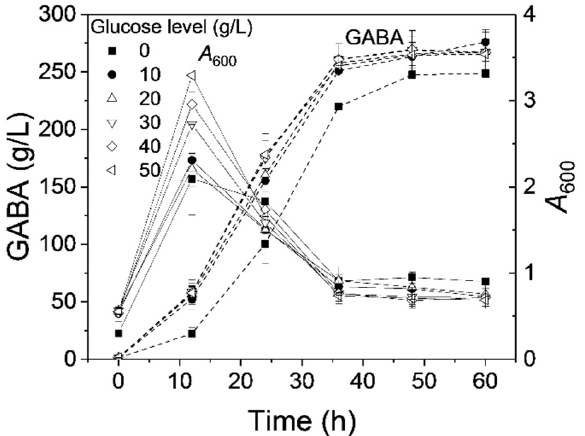
Figure 6. The effect of seed medium glucose content on GABA production and cell growth. Inocula prepared using seed media with different levels of glucose were used for the fermentation experiment, which was performed in a 250 mL Erlenmeyer fermentation flask at 30.0 °C. Cell growth was expressed as A 600 . Vertical bars represent standard deviations of means ( n = 3). There was no significant difference in 48 h GABA concentration between the different glucose levels examined ( p = 0.267). GABA, gamma-aminobutyric acid; A 600 , absorbance at 600 nm.